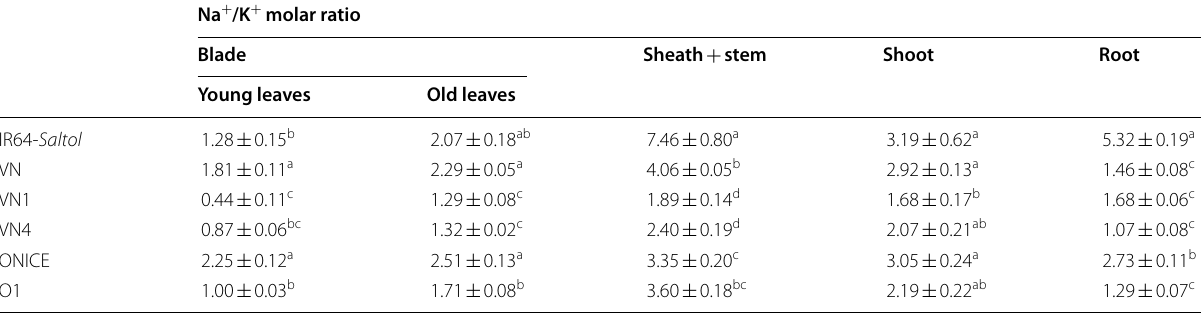
Data are the means ES of three independent experiments (three replicates for three plants each). For each trait, values with same letter(s) are not significantly ± different at p < 0.05, as resulted by a Tukey post-hoc test with a Bonferroni